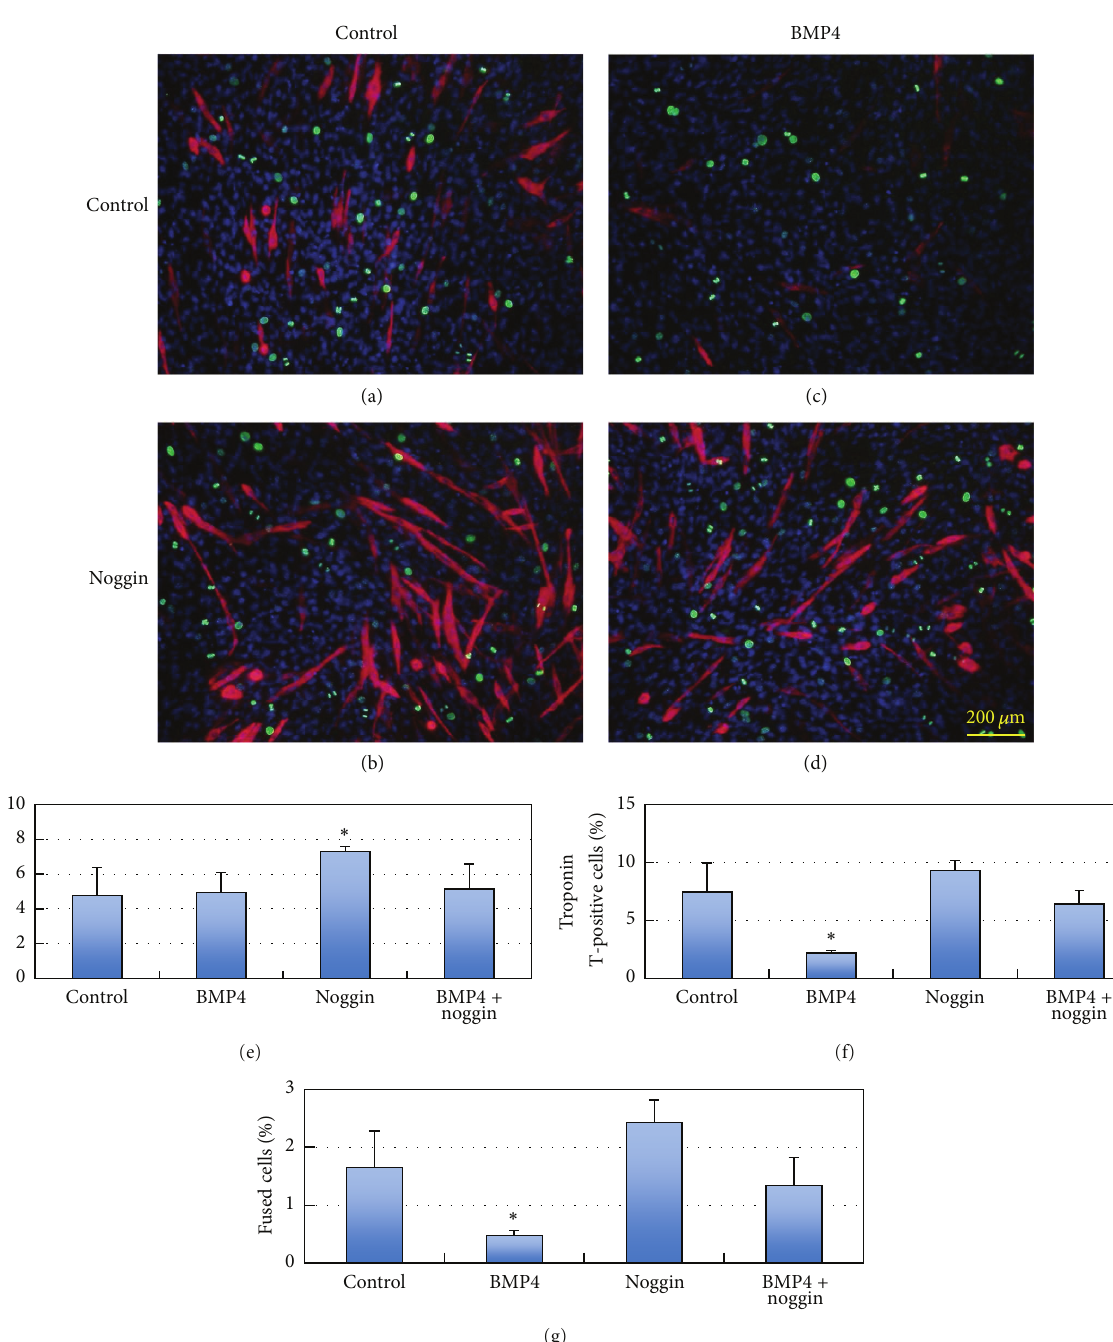
Figure 3: Effect of BMP4 and noggin on the myogenic differentiation of C2C12 cells. (a–d) The recombinant proteins were added to the proliferation medium at final concentrations of 5ng/mL BMP4 and/or 50 ng/mL noggin and cultured in proliferation medium for 3 days, followed by immunostaining with anti-troponin T antibodies (red) and anti-phosphohistone H3 (Ser10) antibodies (green). BMP4 addition inhibited myogenic differentiation in proliferation medium. The number of cells expressing phosphorylated histone H3 was increased by adding noggin but not BMP4. (a) Control; (b) noggin; (c) BMP4; (d) noggin + BMP4. (e–g) The ratios of phosphohistone H3 (e) and troponin T-positive cells (f) to the total cell number were estimated. The number of multinuclear cells expressing troponin T (g) was also estimated to determine the ratio of fused cells among the total cells. Mean + SD ( 𝑛 = 3 ), ∗ 𝑃 < 0.05 versus control with Student’s 𝑡